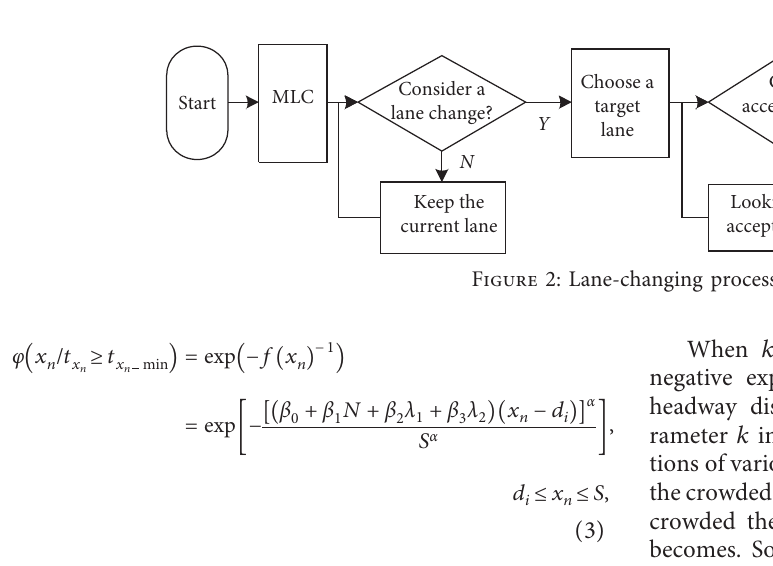
Figure 1: Highway weaving area.